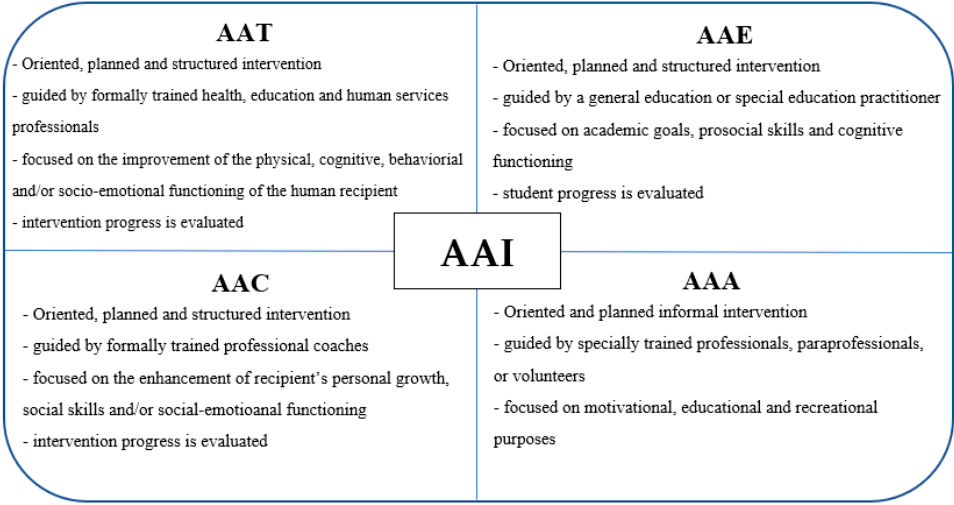
Figure 1. Key features of the various forms of Animal-assisted intervention (AAI).